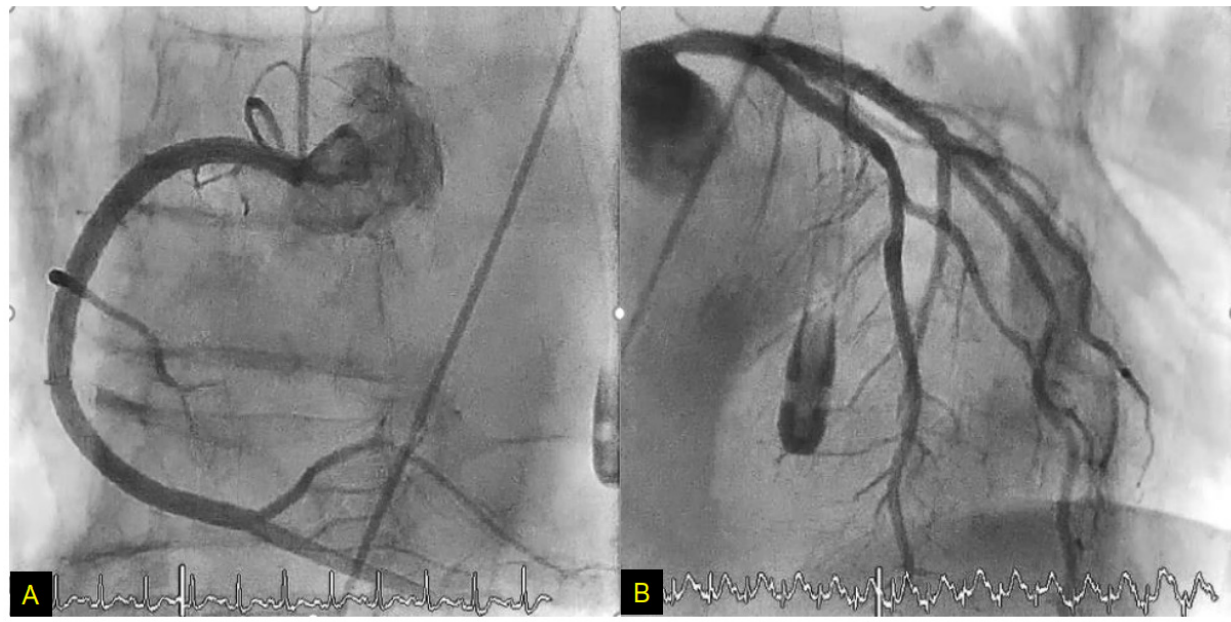
Figure 6. Axial brain MRI in a patient with TTS. Acute cerebral lesions including the right Ic were observed in the diffusion-weighted ( A ) and FLAIR ( B ) images. From [96].